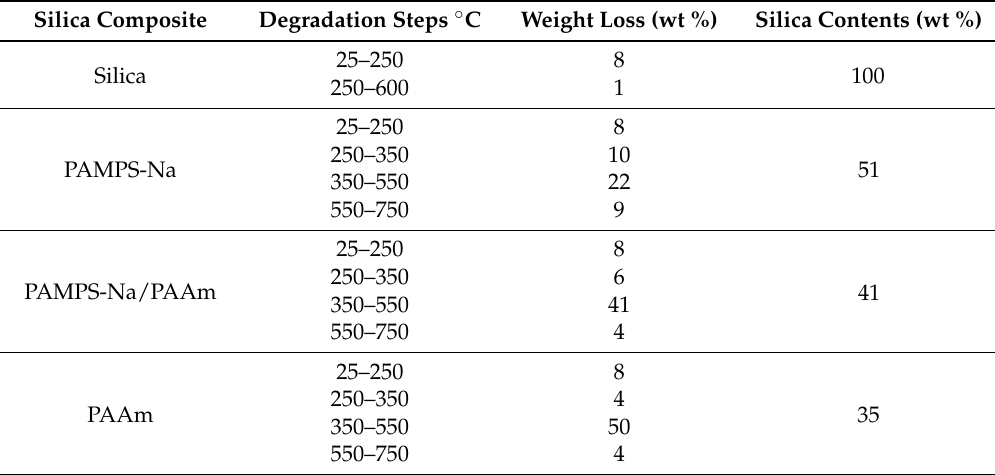
Table 2. Thermogravimetric analysis (TGA) data of silica-nanogel composites. Silica Composite